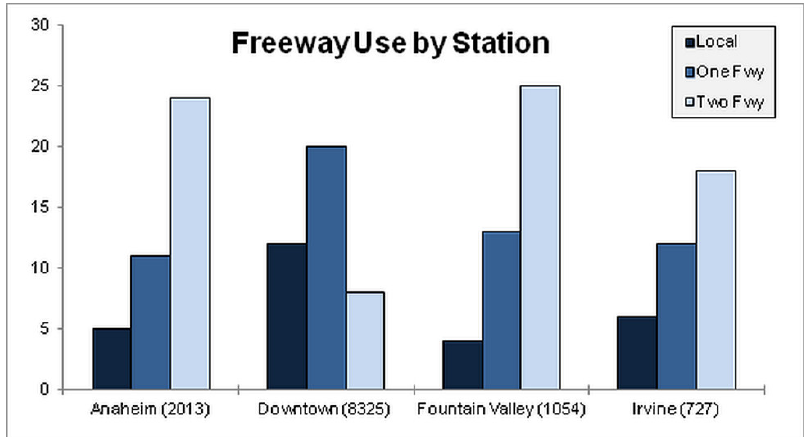
Figure 3. Distribution of trip types by freeway refueling trip type categorization, by station. Number of establishments within one mile of stations indicated in parentheses.